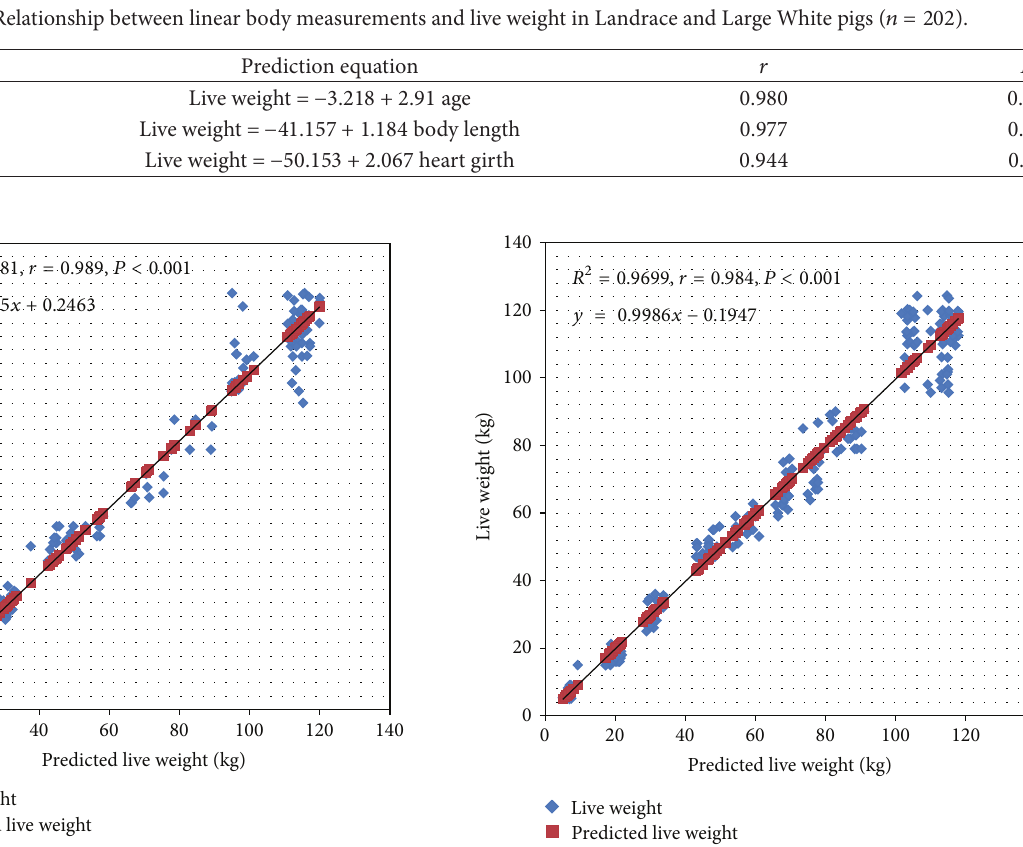
Figure 2: Cross-validation of model 2 ( 𝑛 = 156 ) with the first group of pigs ( 𝑛 = 202